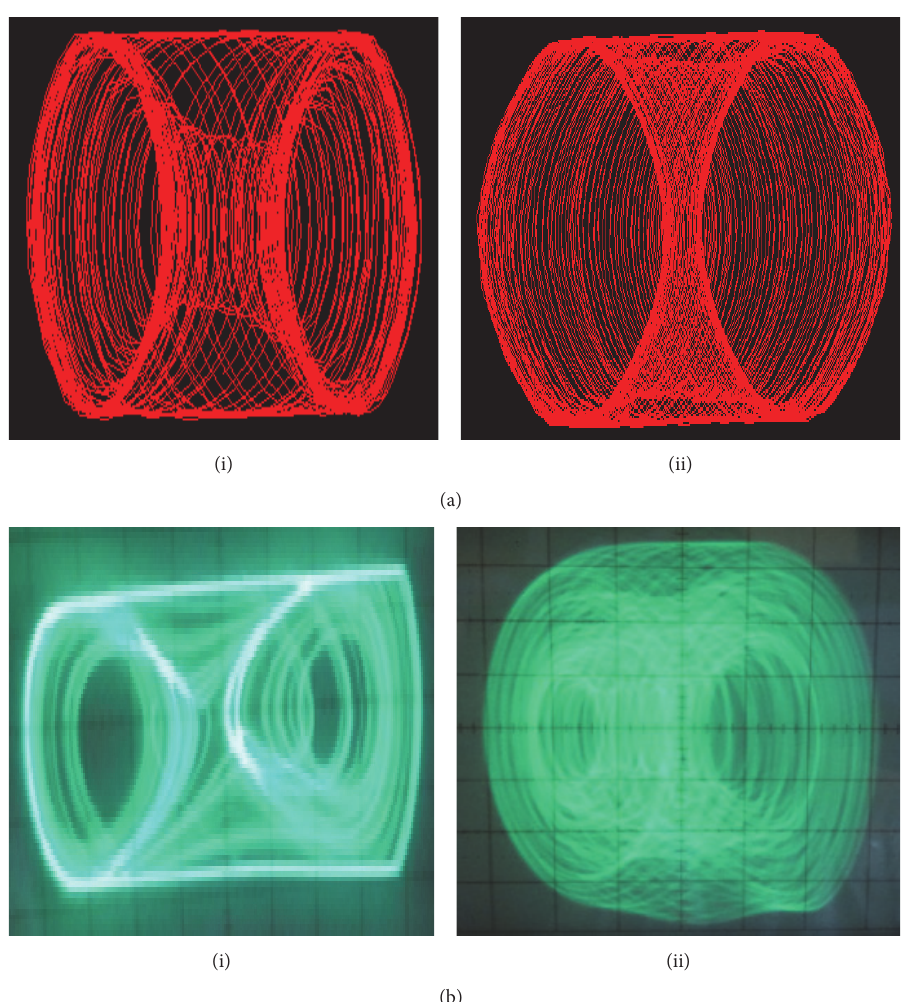
Figure 5: Phase portrait of 𝜙 6 -Van der Pol attractors for (a) computer simulation and (b) experimental implementation for (i) double-well at = 50 Ω and 𝑅 = 200 k Ω and (ii) triple-well at 𝑅 𝑅 8 9